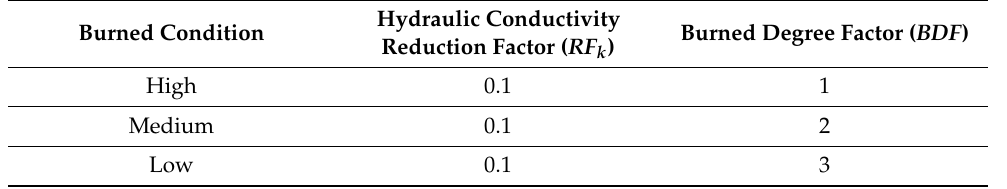
Table 3. Values of the hydraulic Conductivity Reduction Factor and the Burnt Degree Factor of Equation (4) for different burned